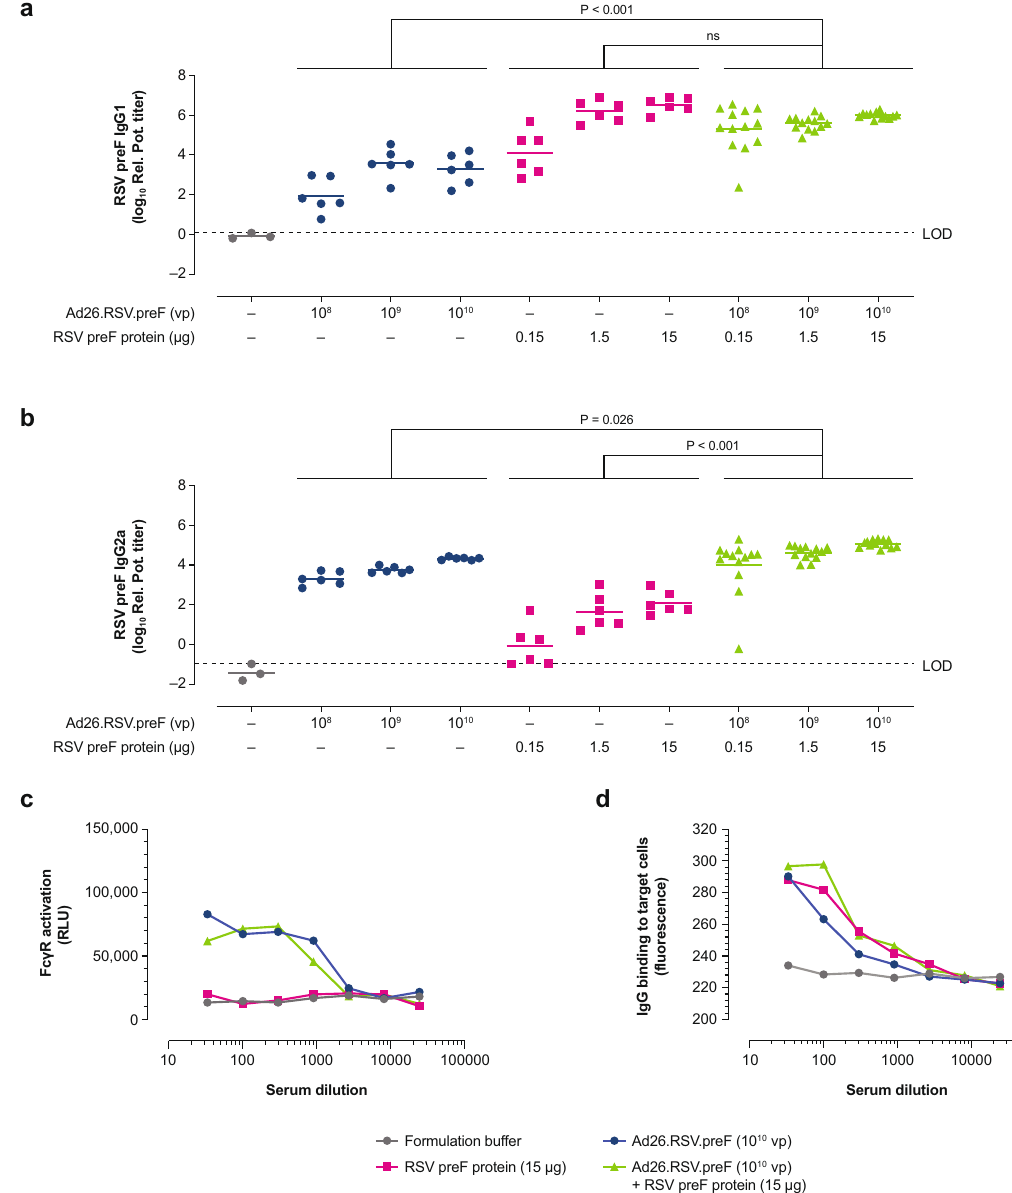
Fig. 2 IgG subclass responses and Fc γ R engagement of antibodies induced by Ad26.RSV.preF/RSV preF protein combinations in naïve mice. Naïve female BALB/c mice were immunized at Week 0 and Week 6 with Ad26.RSV.preF (1 × 10 8 , 1 × 10 9 , or 1 × 10 10 vp; n = 6 in each group), RSV preF protein (0.15, 1.5, or 15 µg; n = 6 each), or Ad26.RSV.preF combined with RSV preF protein at varying dose levels ( n = 13 each). IgG1 ( a ) and IgG2a ( b ) preF-binding antibody titers, expressed as relative potency titer, were measured in serum by ELISA at Week 8. Horizontal lines indicate mean antibody responses per group, and the dotted line indicates the LOD, speci fi ed as the titer of the sample with the highest titer in the formulation buffer control group. Serum obtained at Week 8 from mice immunized with the highest vaccine concentration (Ad26.RSV.preF [1 × 10 10 vp] and RSV preF protein [15 ug], alone or in combination) was pooled and used to measure Fc γ RIV activation in an ADCC reporter assay ( c ), expressed as RLU. Total IgG binding to RSV F-expressing target cells ( d ) was measured by fl uorescence using AF488-conjugated goat anti-mouse IgG. Average of duplicate measurements is shown. Statistical comparisons were made across dose by ANOVA for potentially censored measurements (Tobit model) with Bonferroni correction for multiple comparisons (at an overall signi fi cance level of α = 0.05). Ad26, adenovirus type 26; ADCC, antibody-dependent cellular cytotoxicity; ELISA, enzyme- linked immunosorbent assay; Fc γ R, Fc γ receptor; Fc γ RIV, Fc γ receptor IV; IgG, immunoglobulin G; LOD, limit of detection; ns, not signi fi cant; preF, prefusion conformation-stabilized RSV F protein; Rel. Pot., relative potency; RLU, relative light units; RSV, respiratory syncytial virus; vp, viral and immune responses were compared with responses induced Immunization with Ad26.RSV.preF/RSV preF protein combinations shows robust and durable immune responses in RSV pre-exposed African green monkeys Ad26.RSV.preF/RSV preF protein combinations were evaluated in RSV pre-exposed adult and aged African green monkeys (AGMs),